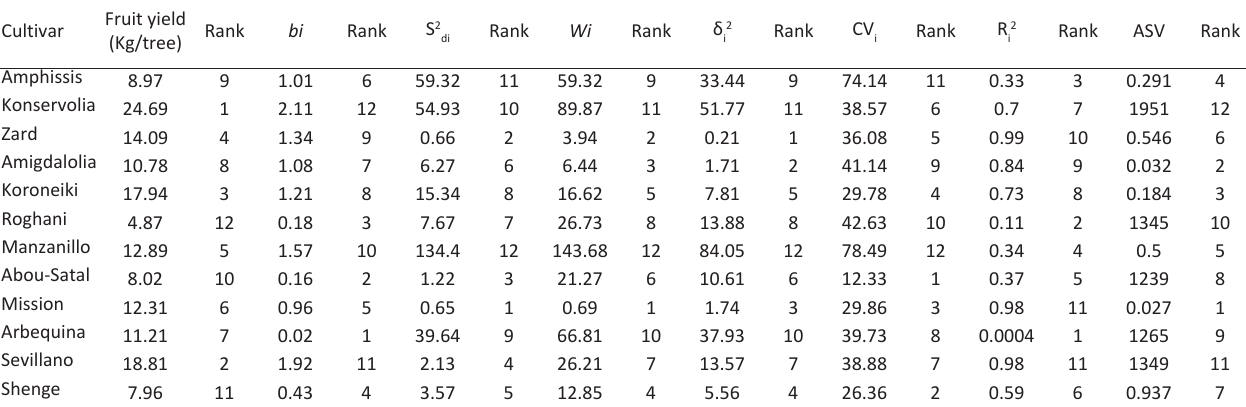
Table 7 - Mean yields (kg/tree) and various stability measurements and their ranking orders of 12 olive cultivars evaluated during five years 2006-2008 Fruit yield Cultivar rank bi (Kg/tree) Amphissis